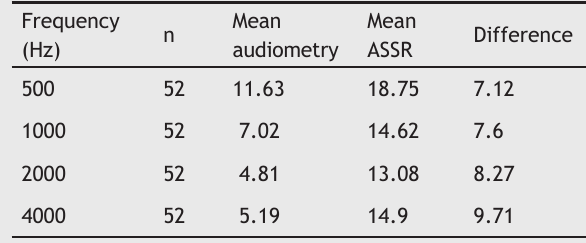
Table 2 Mean thresholds obtained for each frequency in each test and the corresponding difference between the means (p = 0.30 - ANOVA, n = 52 ears).